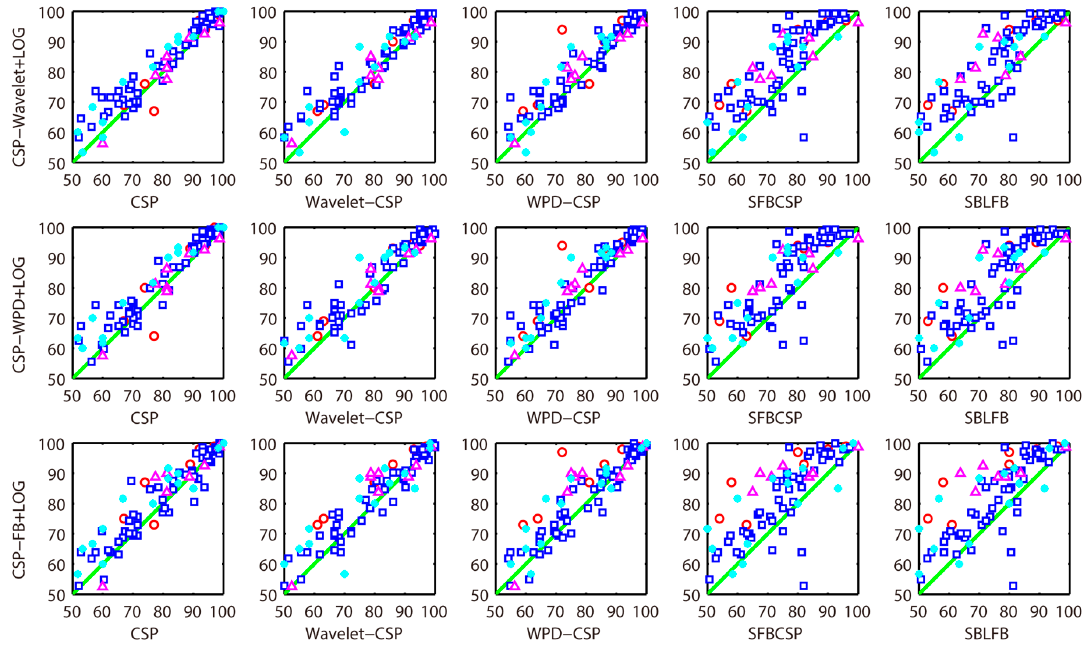
Figure 6. Classification accuracy comparison (All data).